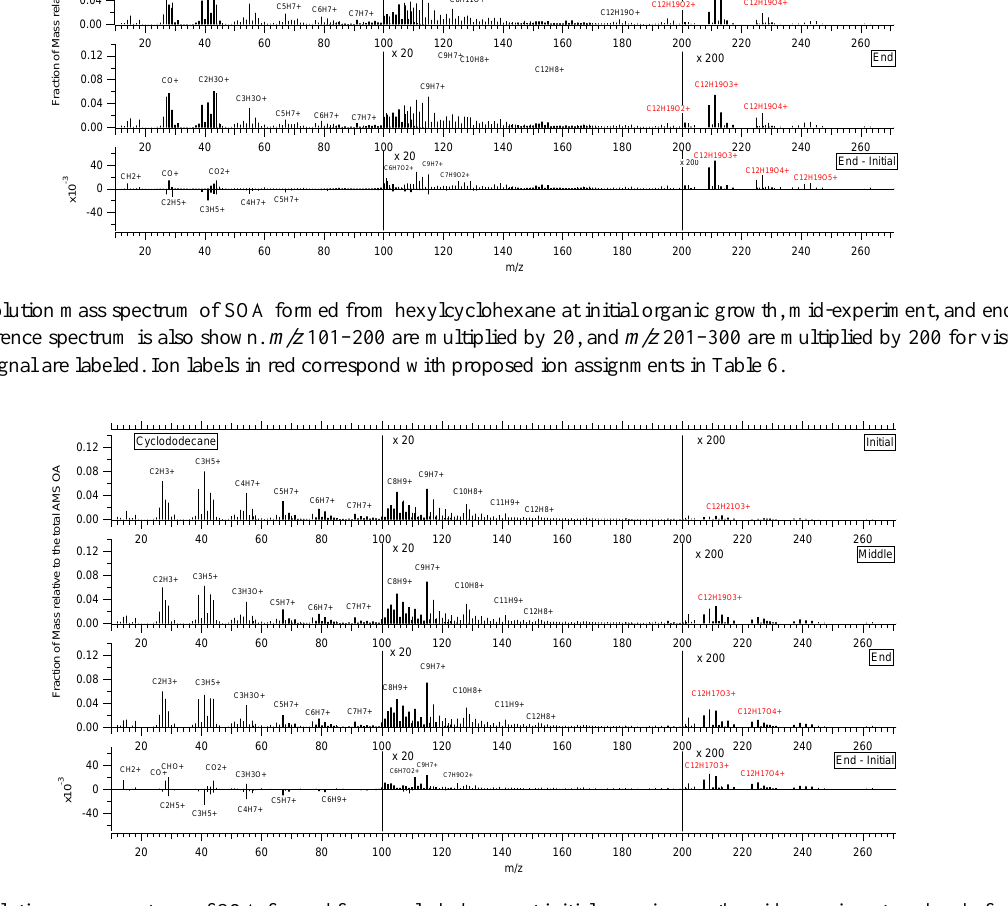
Fig. 7. High-resolution mass spectrum of SOA formed from cyclododecane at initial organic growth, mid-experiment, and end of experiment. The difference spectrum is also shown. m/z 101–200 are multiplied by 20, and m/z 201–300 are multiplied by 200 for visual clarity. Ions with high signal are labeled. Ion labels in red correspond with proposed ion assignments in Table